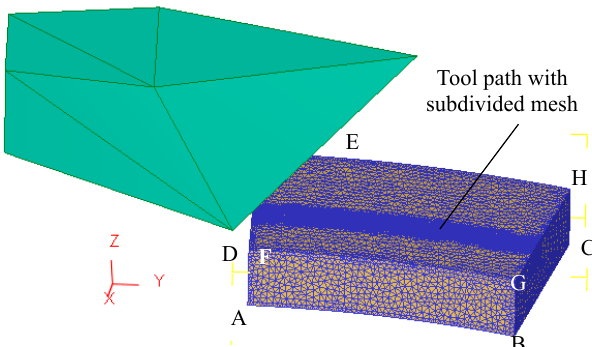
Figure 8. Finite element mesh model of the workpiece.